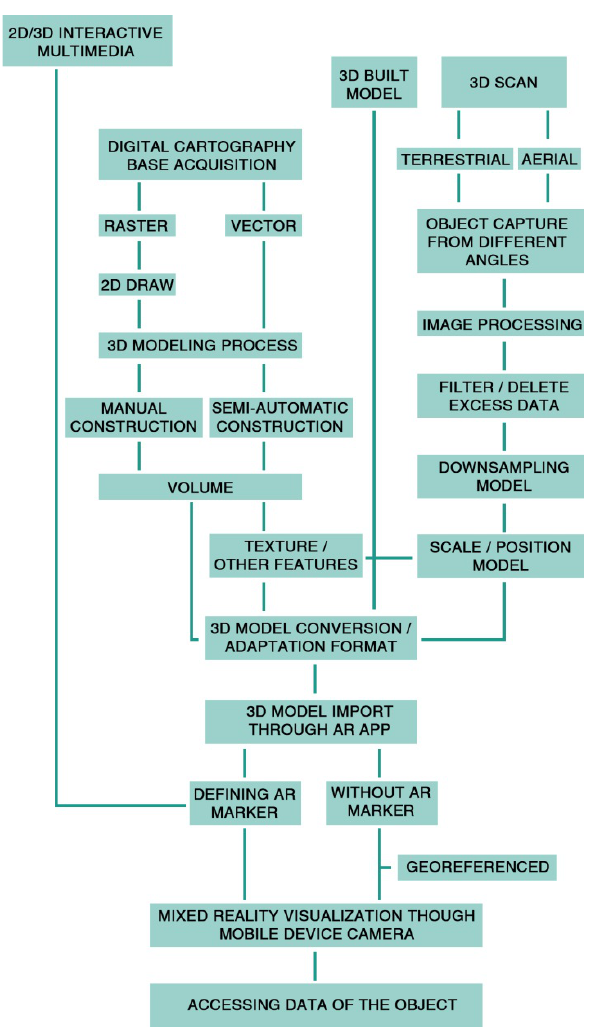
Figure 17. Approach to model and their visualisation in an augmented reality